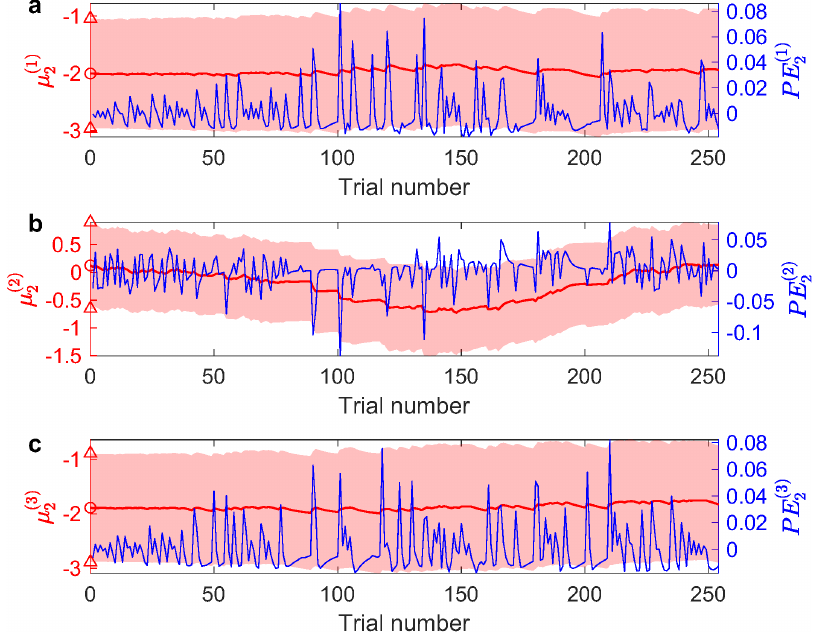
Figure 7. Temporal dynamics of the expectation of the logarithm of volatility µ parameter x 1 at the second level. Each panel shows the evolution of one element of µ the corresponding element of PE 2 in blue. Light-red shaded area represents the uncertainty of each (cid:113) ( i ) ( i , i ) ( t ) ( t ) , i C quantity (i.e., µ 1,2,3 ). The red markers 2 2 ∈ { ± } standard deviation and mean of each quantity.